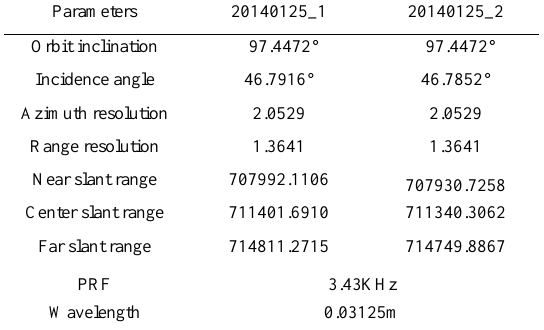
Table 1. Detailed information of TerraSAR-X/TanDEM-X